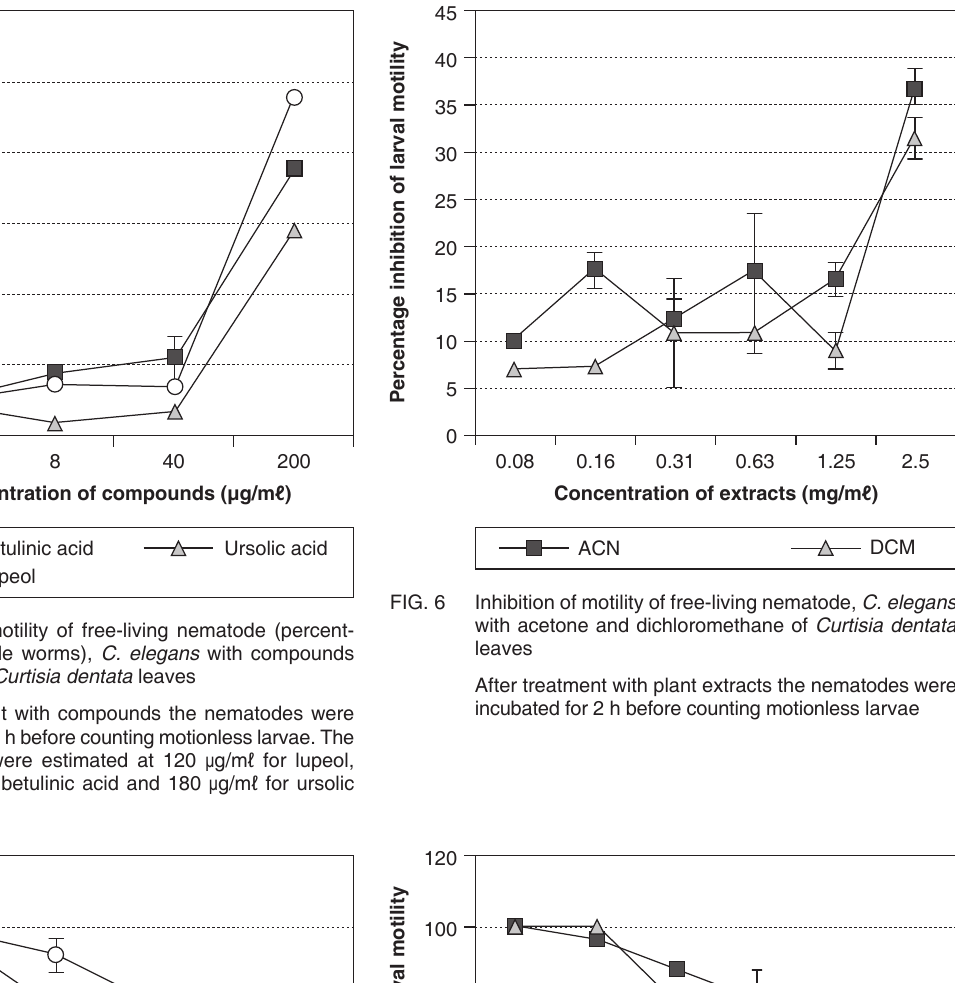
After treatment with compounds the nematodes were